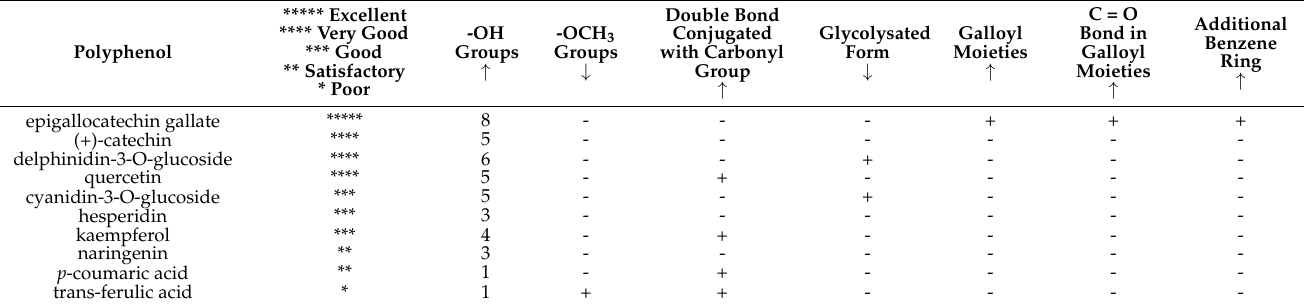
Table 3. Inhibitory activity related to molecular structure